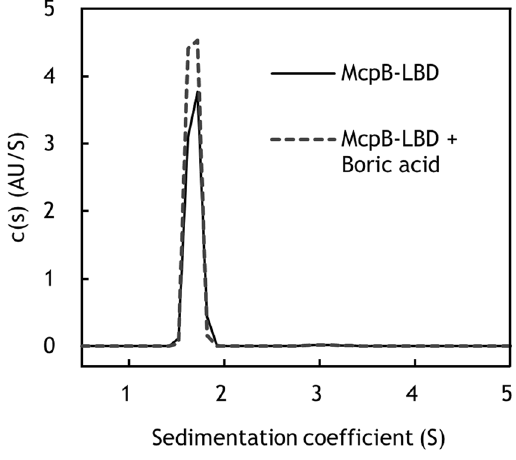
Figure 6. Determination of the oligomeric state of McpB LBD using analytical ultracentrifugation. Shown are sedimentation coefficient distributions for 1.5 mg/ml McpB LBD in the absence and presence of 1 mM boric